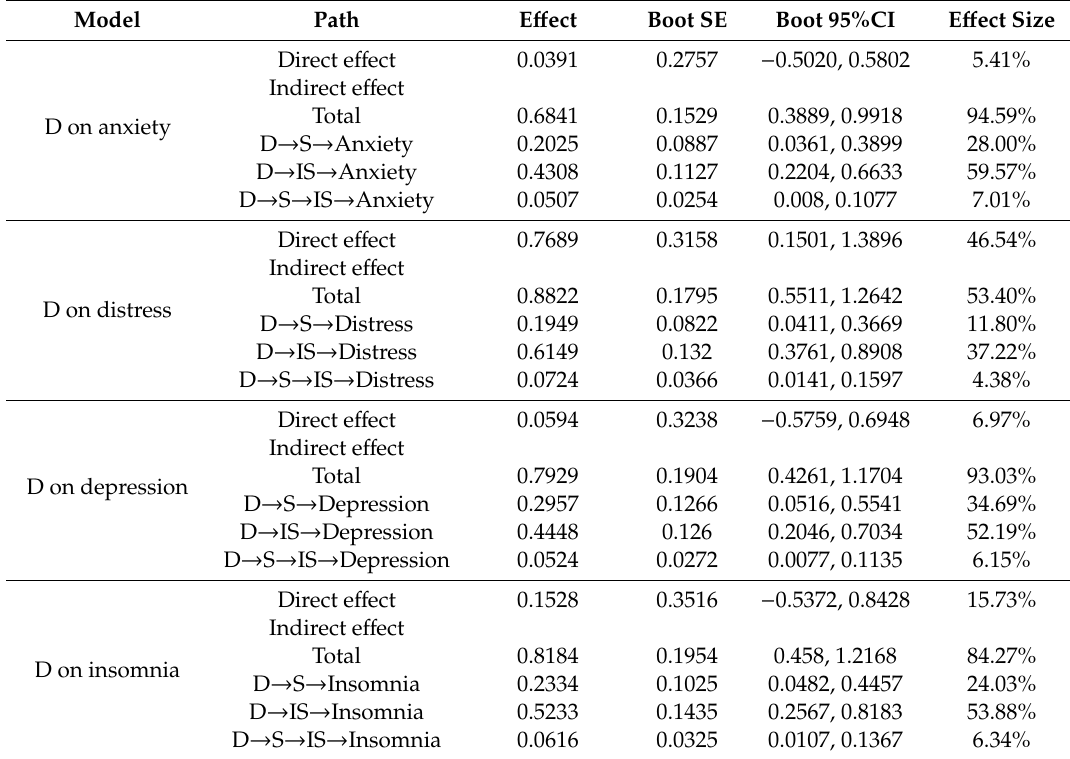
Table 4. Direct and indirect e ff ects of coronavirus disease 2019 (COVID-19)-related discrimination on anxiety, distress, depression, and insomnia through the mediating e ff ects of shame and internalized